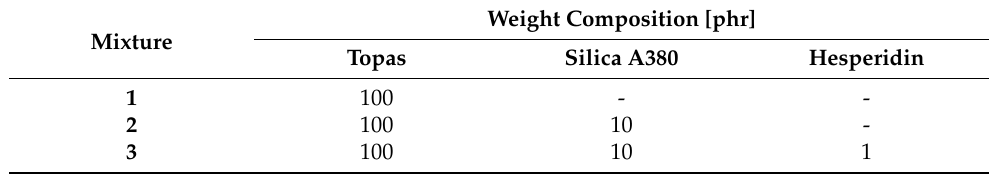
Figure 10. Structural formulas of: ( a ) polymer matrix—ethylene-norbornene copolymer (Topas), ( b ) natural flavonoid—hesperidin with antioxidant properties. Table 6. The composition of Topas-based blends with natural antioxidant-hesperidin and a filler in the form of